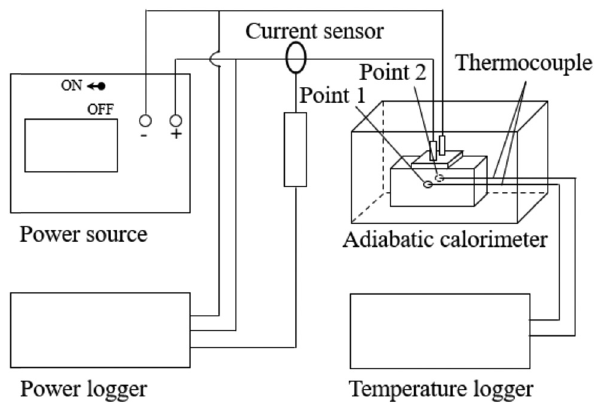
Figure 2: Power measurement circuit. Figure 3: An example of temperature change. The solid and dashed lines correspond to the temperatures associated at Points 1 and 2, respectively, of the power measurement circuit.